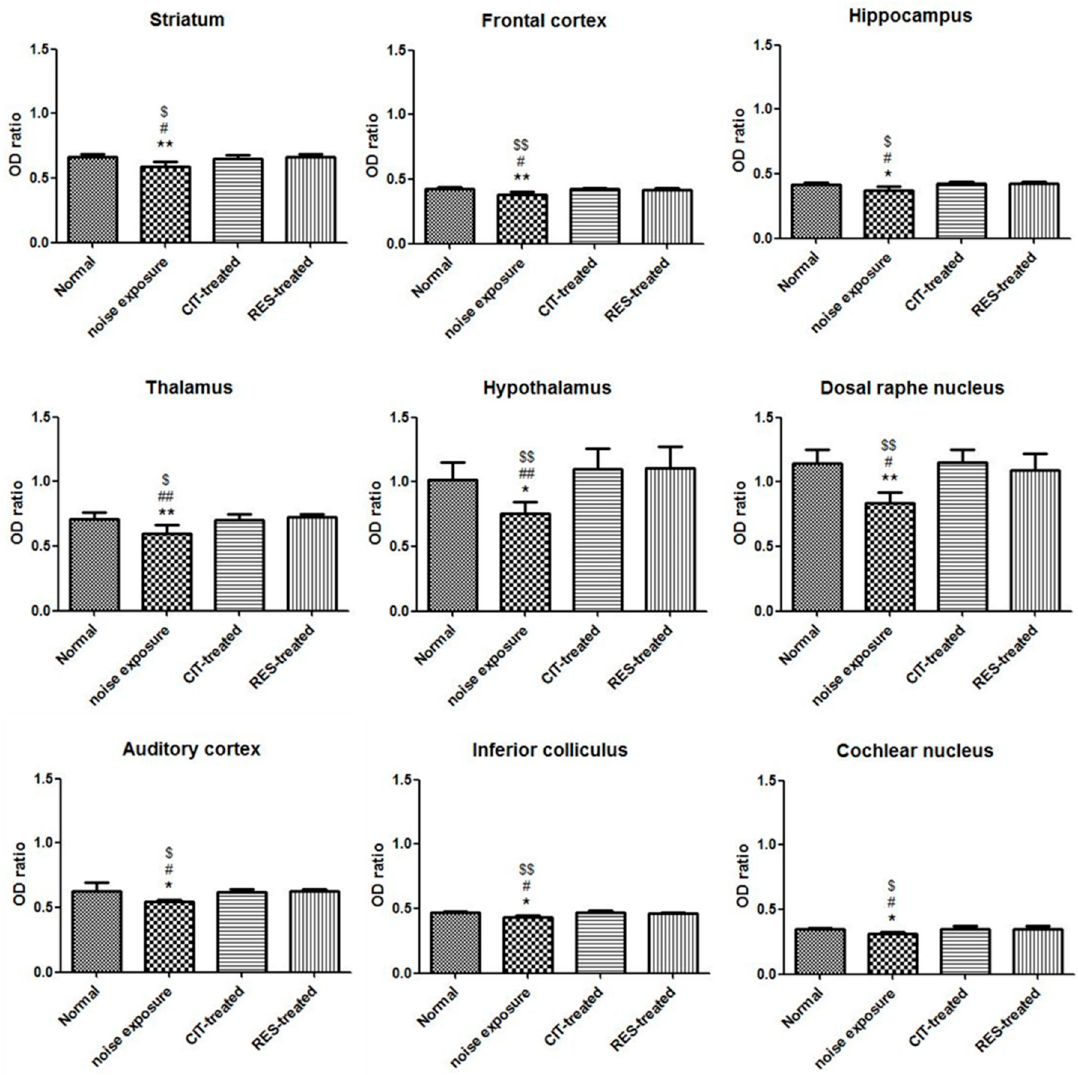
Figure 5. The graphs display OD ratios in various brain regions at day 4 after noise exposure. The OD ratios in various brain regions were significantly lower than those of the NE group. * p < 0.05, ** p < 0.01, *** p < 0.001 for comparisons between the control group and NE group; $ p < 0.05, $$ p < 0.01, $$$ p < 0.001 for comparisons between the NE group and CIT-treated group; # p < 0.05, ## p < 0.01, ### p < 0.001 for comparisons between the RES-treated group and NE group. (OD: optical density, CIT: citalopram, RES: resveratrol, NE: noise exposure).